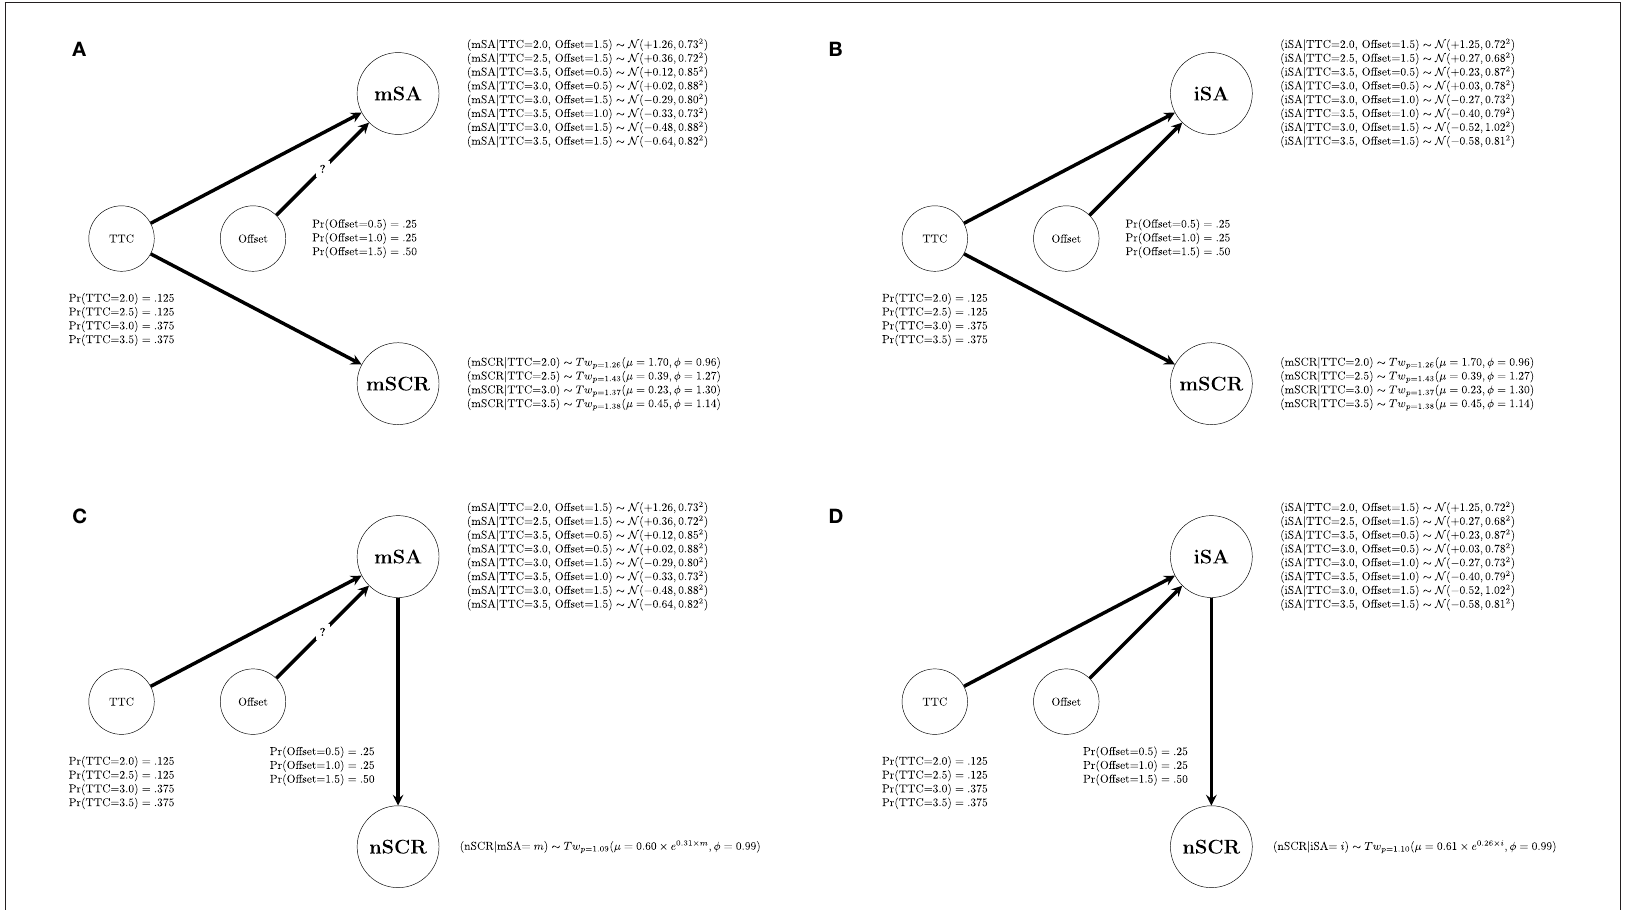
FIGURE A1 | The four best directed acyclic graphs with detailed distributions. (A) The relationships between the factors and the indicators mSA and mSCR. (B) The relationships between the factors and the indicators iSA and mSCR. (C) The relationships between the factors and the indicators mSA and nSCR. (D) The relationships between the factors and the indicators iSA and nSCR. The question mark on the relationship between node Offset and node mSA indicates that the degree of evidence for this relationship is not sufficient according to the BIC thresholds developed by Raftery